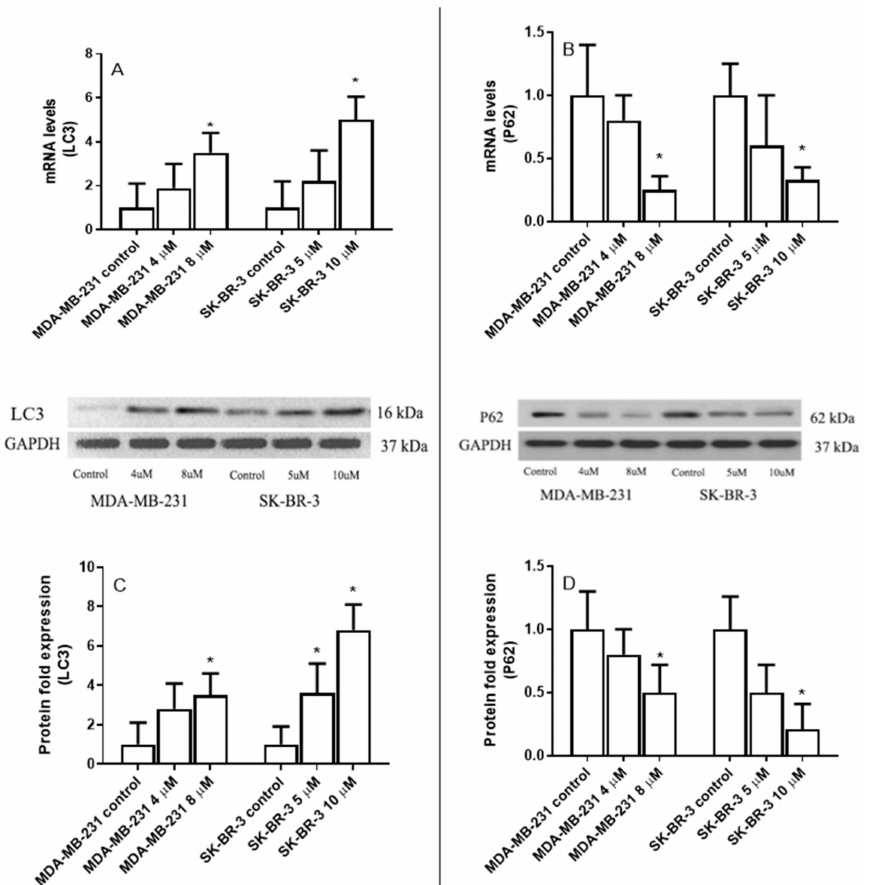
Figure 4. The effect of eugenol treatment on LC3 and p62 mRNA and protein expression levels. MDA-MB231 and SK-BR-3 cells were treated for 24 h ( A , B ). Thereafter, LC3 and p62 mRNA expression levels were quantified by RT-PCR. The protein expression levels of LC3 and p62 were then assessed in MDA-MB231 and SK-BR3 cells treated for 24 h with 0, 4, and 8 µ M and 0, 5, and 10 µ M eugenol, respectively ( C , D ). * indicates a significant change compared to untreated cells (0 µ M) at p < 0.05 based on a one-way ANOVA and the Tukey–Kramer post-ANOVA